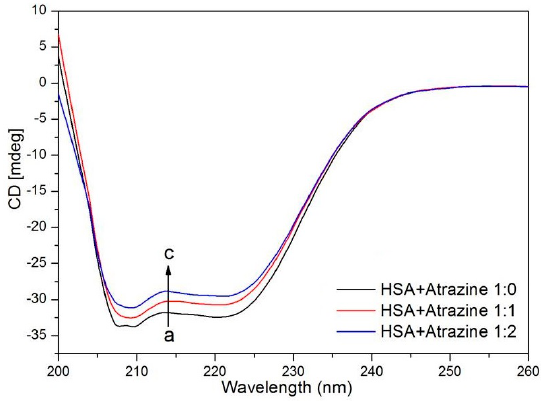
Figure 8. Far ‐ UV CD spectra of HSA in the presence of different concentrations of ATR. Figure 8. Far-UV CD spectra of HSA in the presence of different concentrations of ATR.